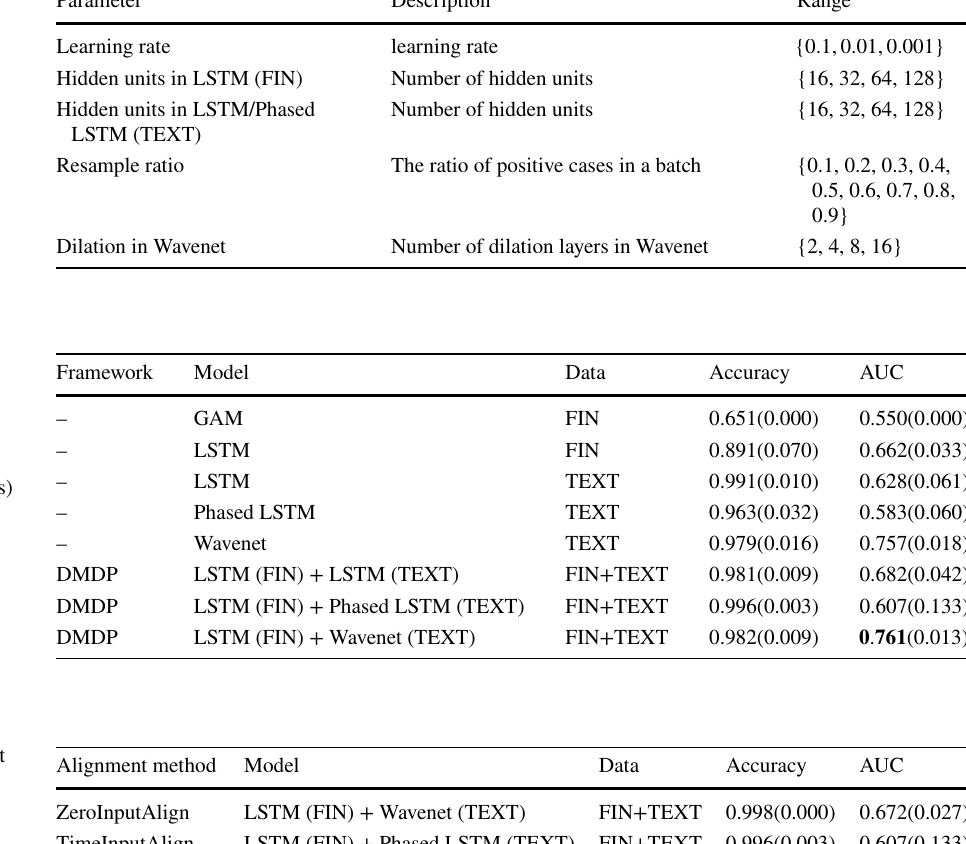
Table 2 Parameter ranges